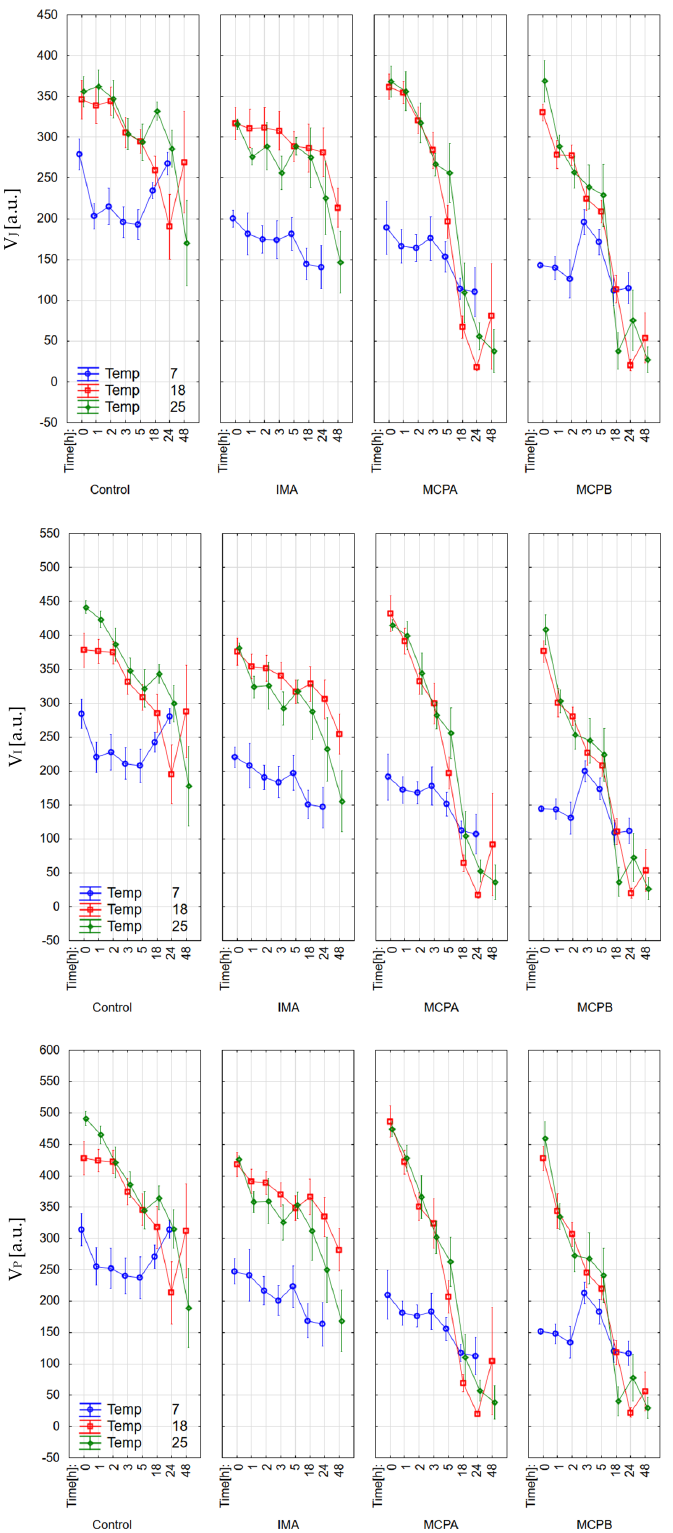
Figure 2. Chlorophyll fluorescence signals (absolute values of V J , V I and V P ) as affected by the exposure of G. orientalis plants to MCPA, MCPB and IMA. The plants were cultivated at three different temperatures (7, 18 and 25 ◦ C). Data points represent means of five replicates ± standard deviation. The replicates were five leaves, each on a different